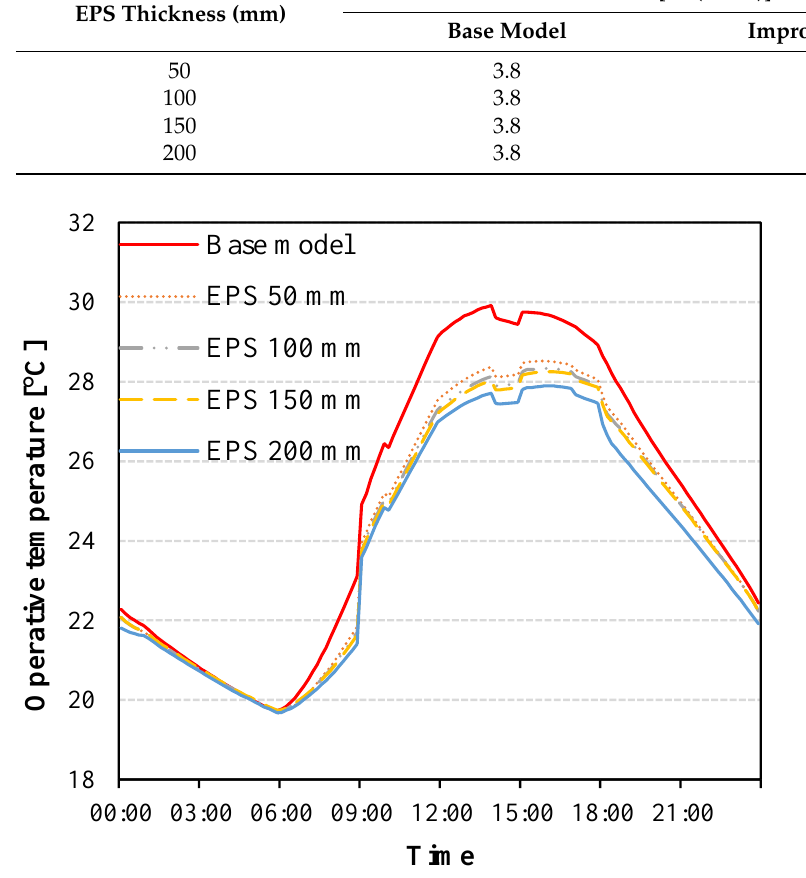
Figure 15. Impact on operative temperature due to ceiling insulation using expanded polystyrene (EPS).